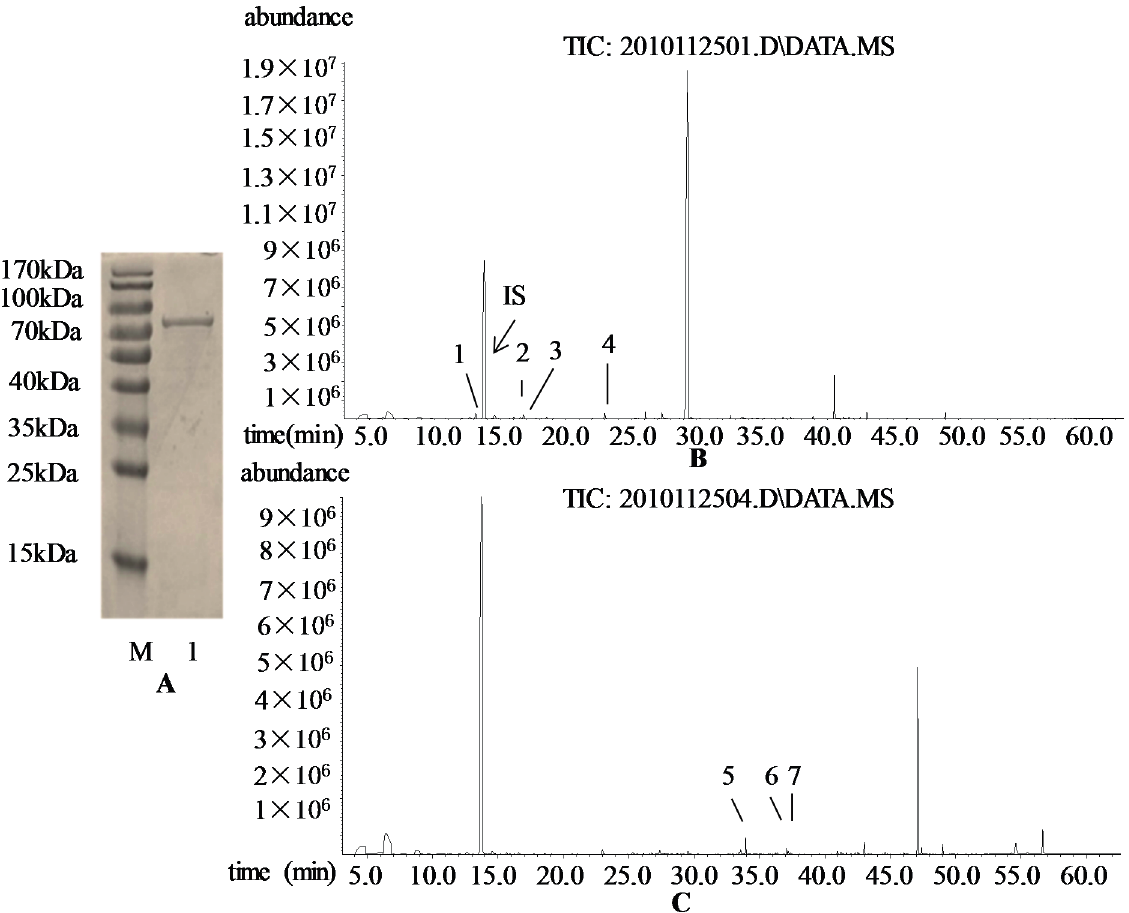
Figure 3. Analysis of SDS polyacrylamide gels of the purified recombinant VvRiLinNer proteins ( A ) and GC-MS analysis of the products of recombinant VvRiLinNer reaction system ( B , C ). In ( A ), M: Protein Molecular Weight Marker; 1: the purified protein VvRiLinNer. The apparent molecular weight of expressed recombinant proteins VvRiLinNer was estimated approximately 82 kDa, which is bigger than the predicted proteins from